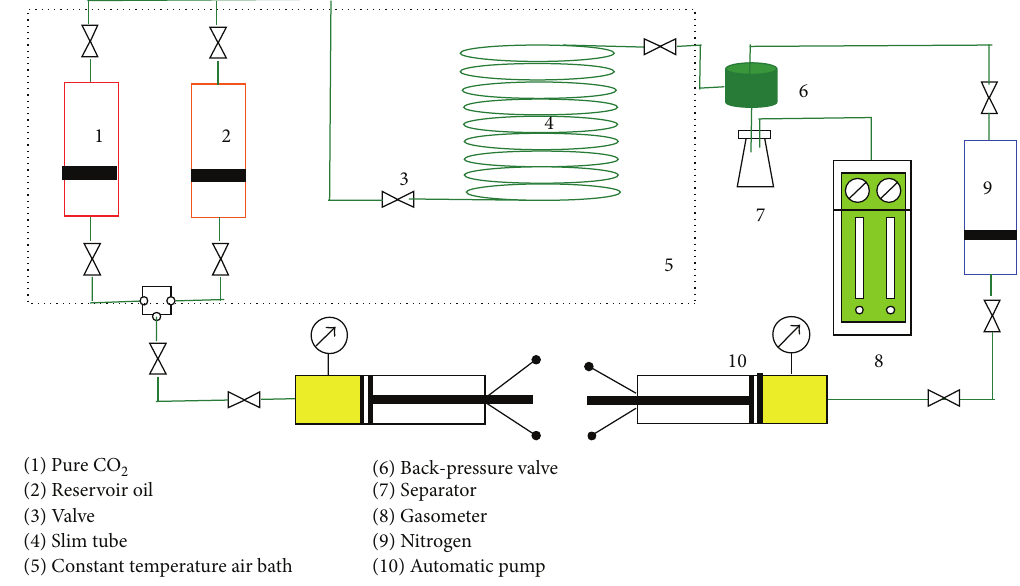
Figure 1: Schematic diagram of the slim tube experimental apparatus.